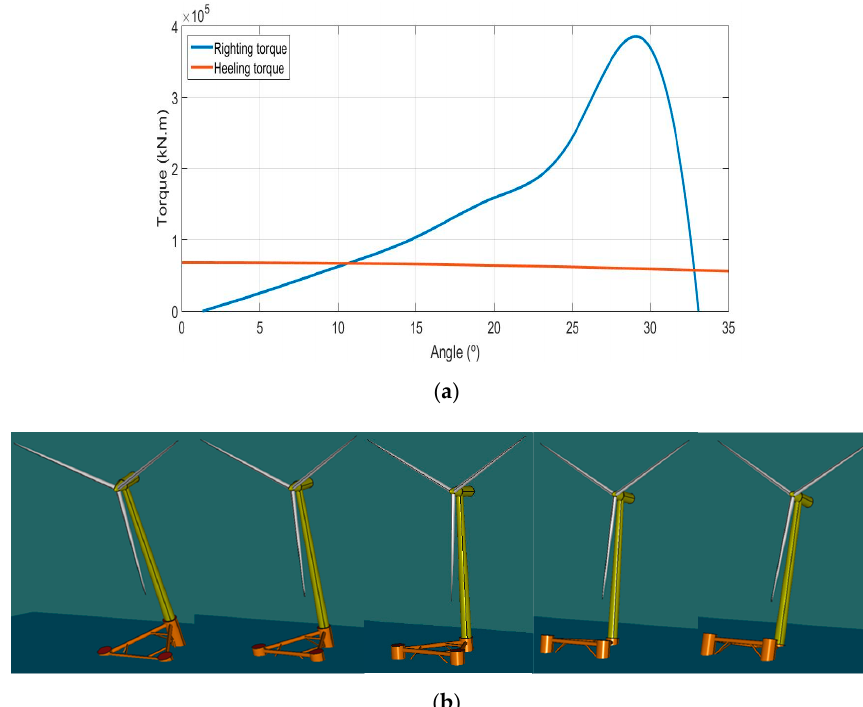
Figure 4. Curve of static stability of the device with respect to x -axis (stable range). ( a ) Curve of static stability for the x -axis and ( b ) rotating platform around the y -axis